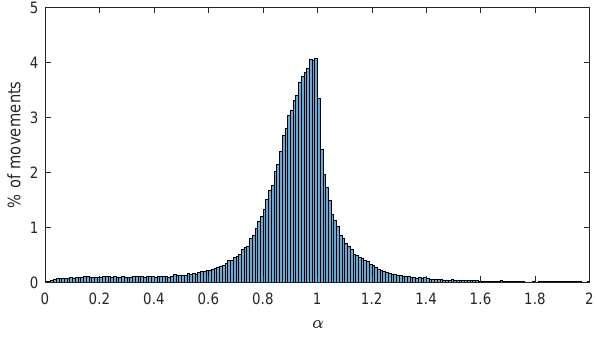
Figure 1. Histogram of trip indexes of trips in the dataset.